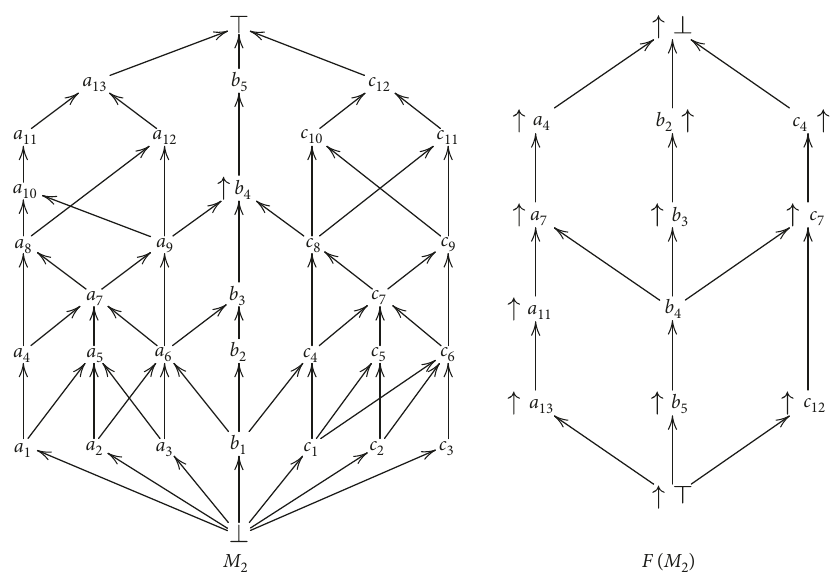
Figure 2: The multilattice M